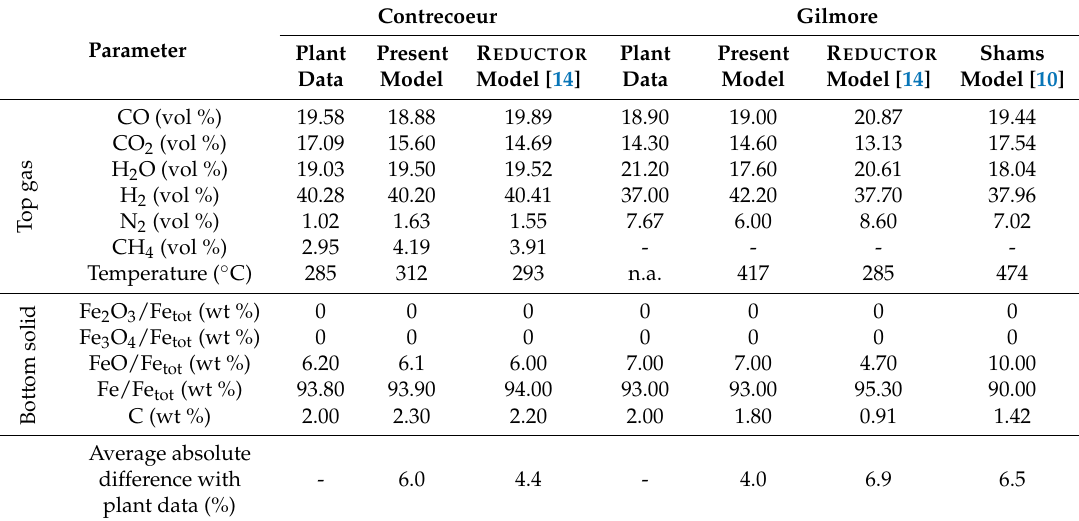
Table 3. Simulation of a shaft furnace. Comparison of the results with industrial data and other model results.